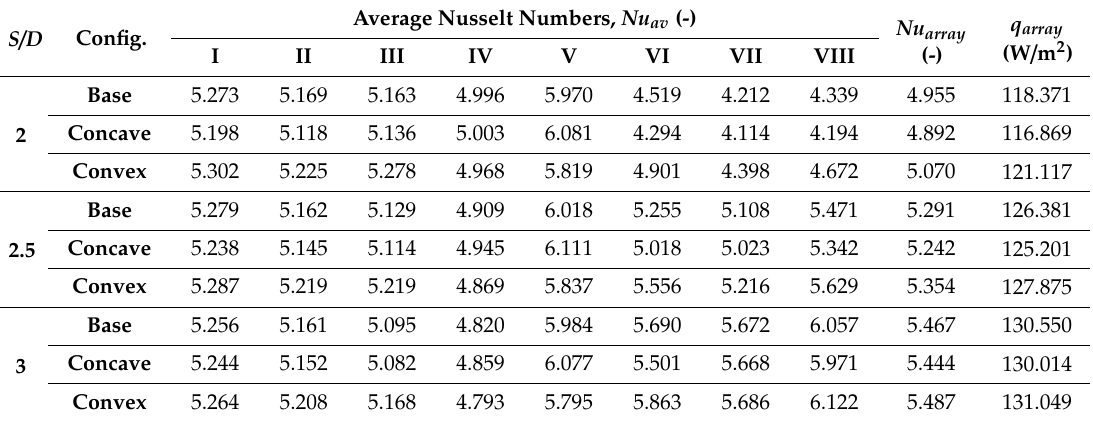
Table 5. Average Nusselt numbers for di ff erent ratios S / D and configurations of 4 × 4 tube arrays at Ra = 3.7 × 10 4 . S / D